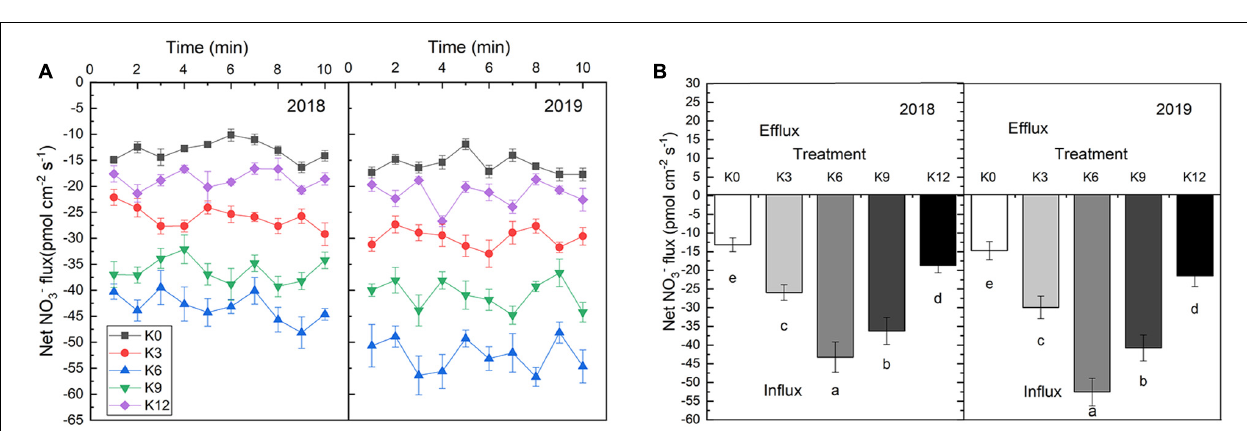
FIGURE 5 | NO 3 − ion flow rate in root of M9T337 seedlings treated with K0 (0 mM K + ), K3 (3 mM K + ), K6 (6 mM K + ), K9 (9 mM K + ), or K12 (12 mM K + ) in 2018 and 2019. (A) Net NO 3 − fluxes in the root of apple seedlings for 10 min. (B) Mean rate of NO 3 − fluxes during the entire 10 min. Data are means ± SD ( N = 6). min = minutes. Different letters indicate statistically significant differences ( P <